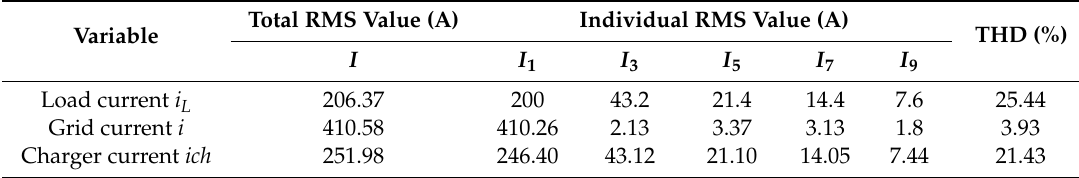
Table 5. Load, grid, and charger current of the harmonic content for case C.